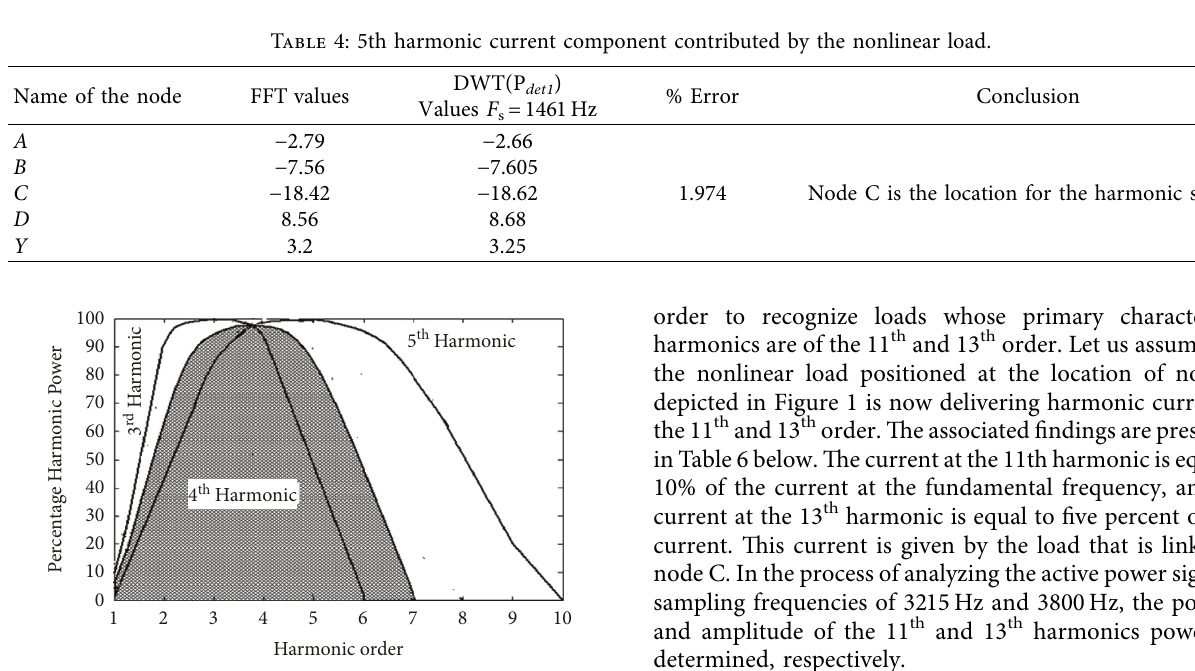
Figure 2: Pseudo-frequency vs. captured harmonic power for 3 rd , 4 th , and 5 th harmonics.